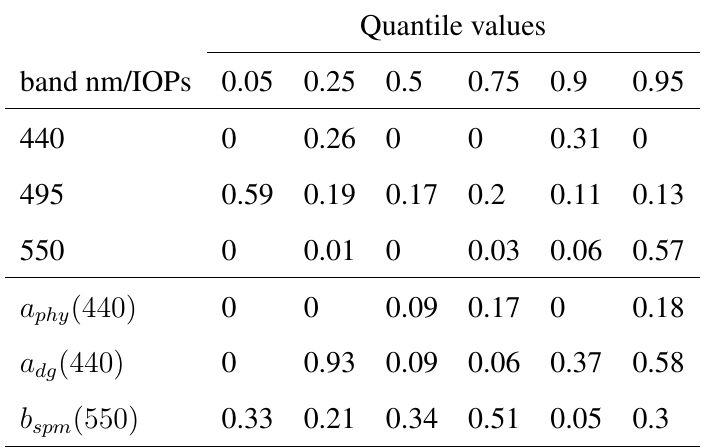
Table 1. Probability of empirical PDF having the same variability of the theoretical PDF.